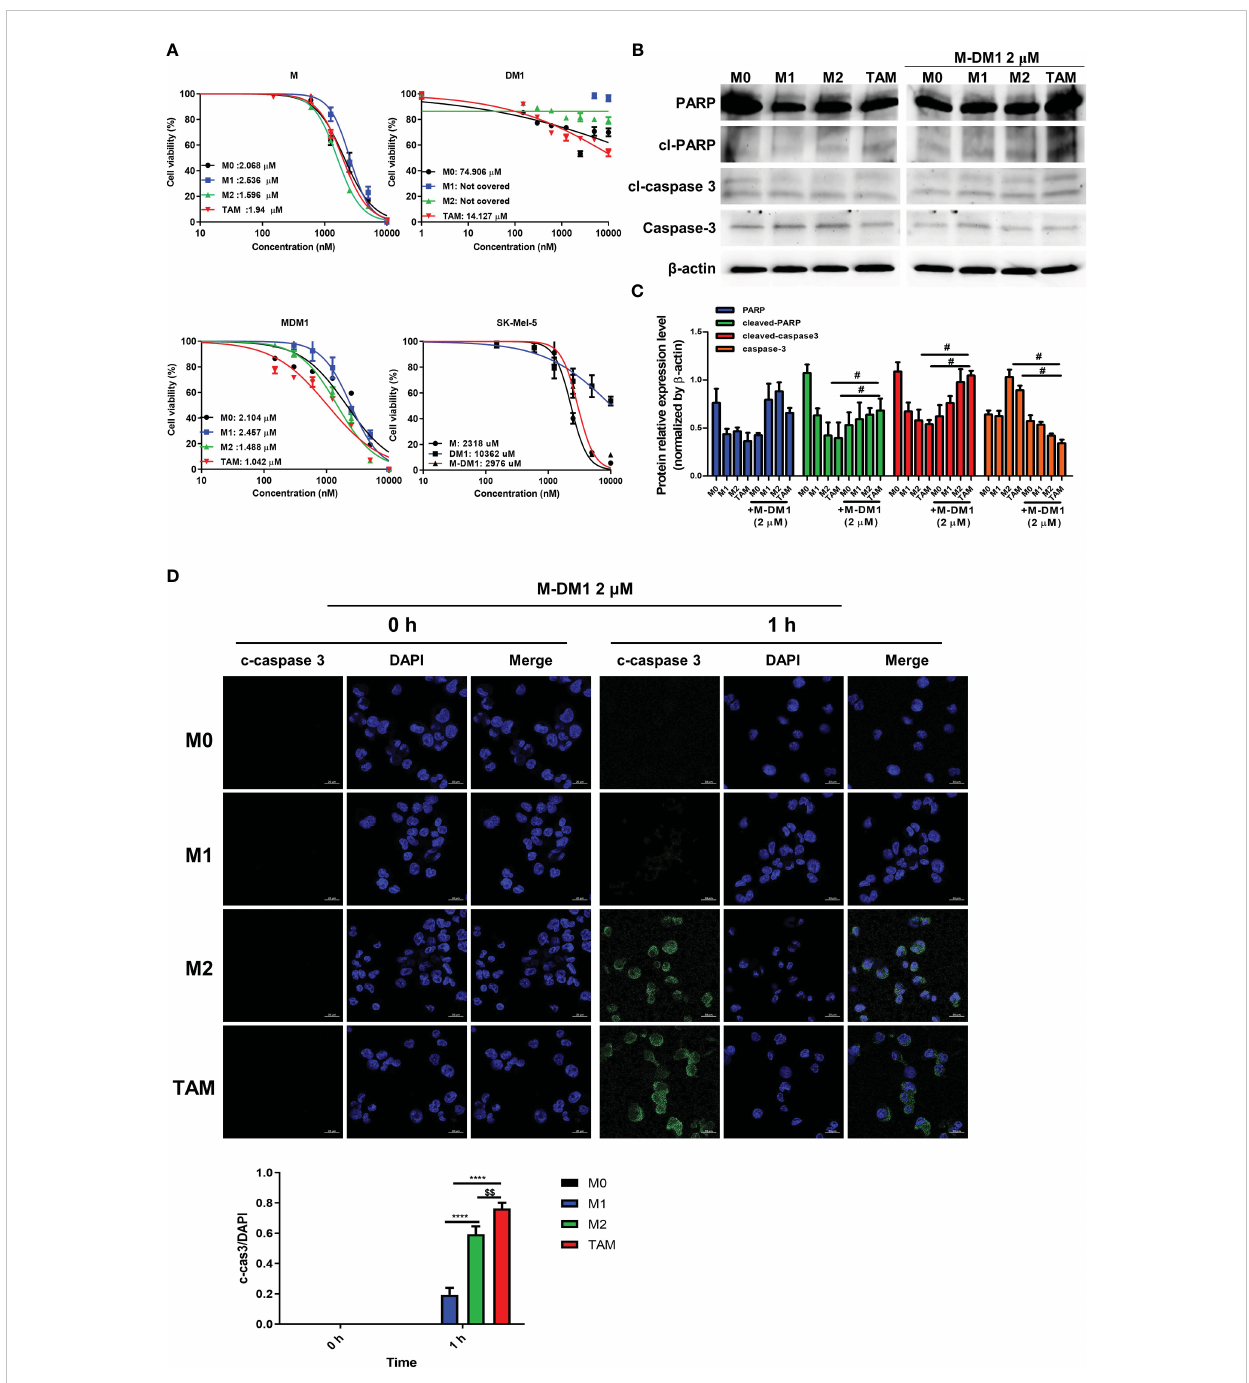
FIGURE 2 M-DM1 induced apoptosis of M2 – like tumor-associated macrophages (TAMs). (A) Human monocytes (THP-1) (3 × 10 4 cells/well) were seeded in a 96-well plate. The cells were treated with 100 nM phorbol-12-myristate-13-acetate for 24 h and polarized into M1, M2 and M2-like TAMs. SK-MEL-5 cells were seeded at a density of 0.5 × 10 4 cells/well in a 96-well plate. Peptides (10, 5, 2.5, 1.25, 0.612, 0.3, and 0.15 m M) were added into each well along with a serum-free medium and incubated for 24 h Cell viability for macrophages with peptides was assessed using an MTS assay. (B) After the treatment of polarized macrophages with M-DM1 for 24 h, proteins were extracted using RIPA buffer. Through western blotting, the expression of apoptosis-related markers PARP, cleaved-PARP, cleaved-caspase-3, and caspase-3 was examined. (C) The expression of target proteins was normalized to b -actin expression. The data are presented as the mean ± SD. One-way ANOVA followed by Tukey ’ s post-hoc test was performed for group comparisons; #p < 0.05 vs untreated TAM group. (D) Cells were treated with M-DM1 (2 m M) for 1 h and stained for cleaved-caspase-3. The data are presented as the mean ± SD. One-way ANOVA followed by Tukey ’ s post-hoc test was performed for group comparisons; $$p < 0.01 vs M2 group; ****p < 0.0001 vs M1